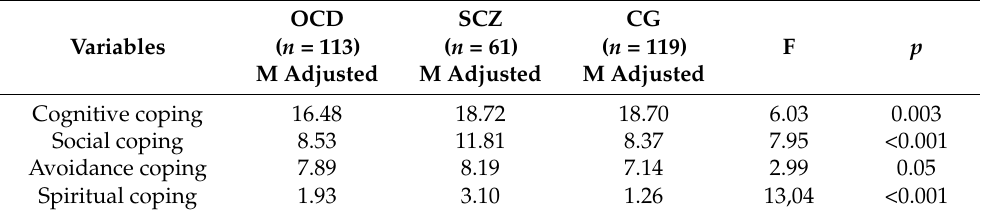
Table 4. ANCOVA coping strategies with experiential avoidance and uncertainty intolerance.